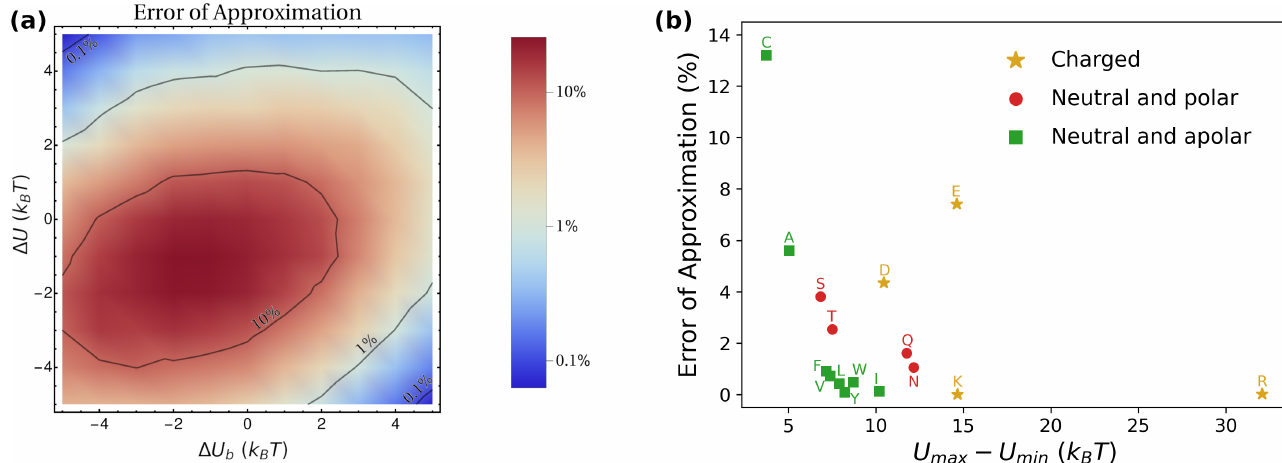
(cid:12) (cid:12) (cid:12) (cid:12) (cid:12) 1 D eff,pred / D eff,sim (cid:12) , where D eff,pred is the